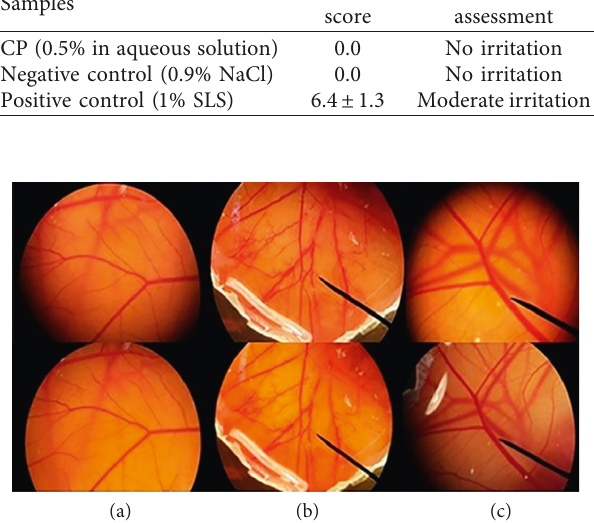
Figure 3: Photographs of CAM after 5min (upper) and after 60min (lower) exposure to (a) negative control (0.9% NaCl), (b) positive control (1% SLS), and (c) CP in aqueous solution